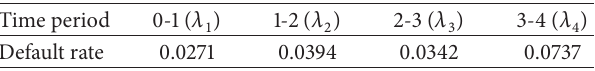
Table 3: Default rate of corporate bonds under constant volatility interest rate model.